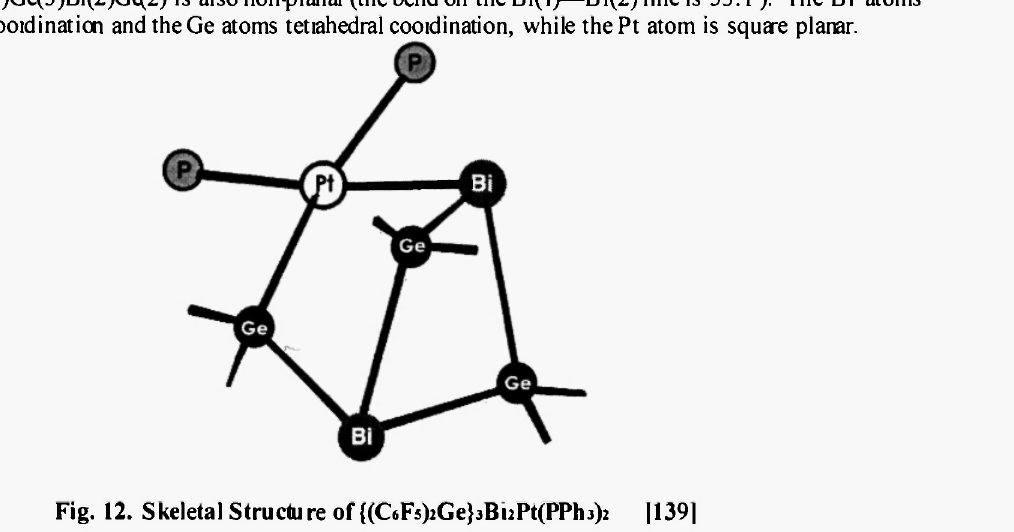
Fig. 12. Skeletal Structure of {(CiFs^GeJjBuPtiPPhi):